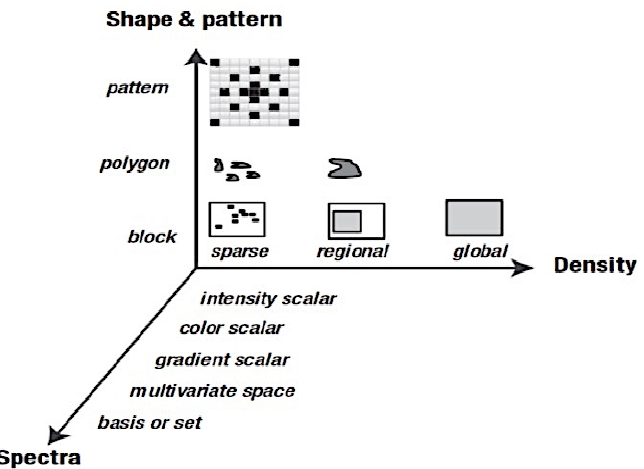
Figure 9. Taxonomy for feature descriptor dimensions created by Krig, S. [96].